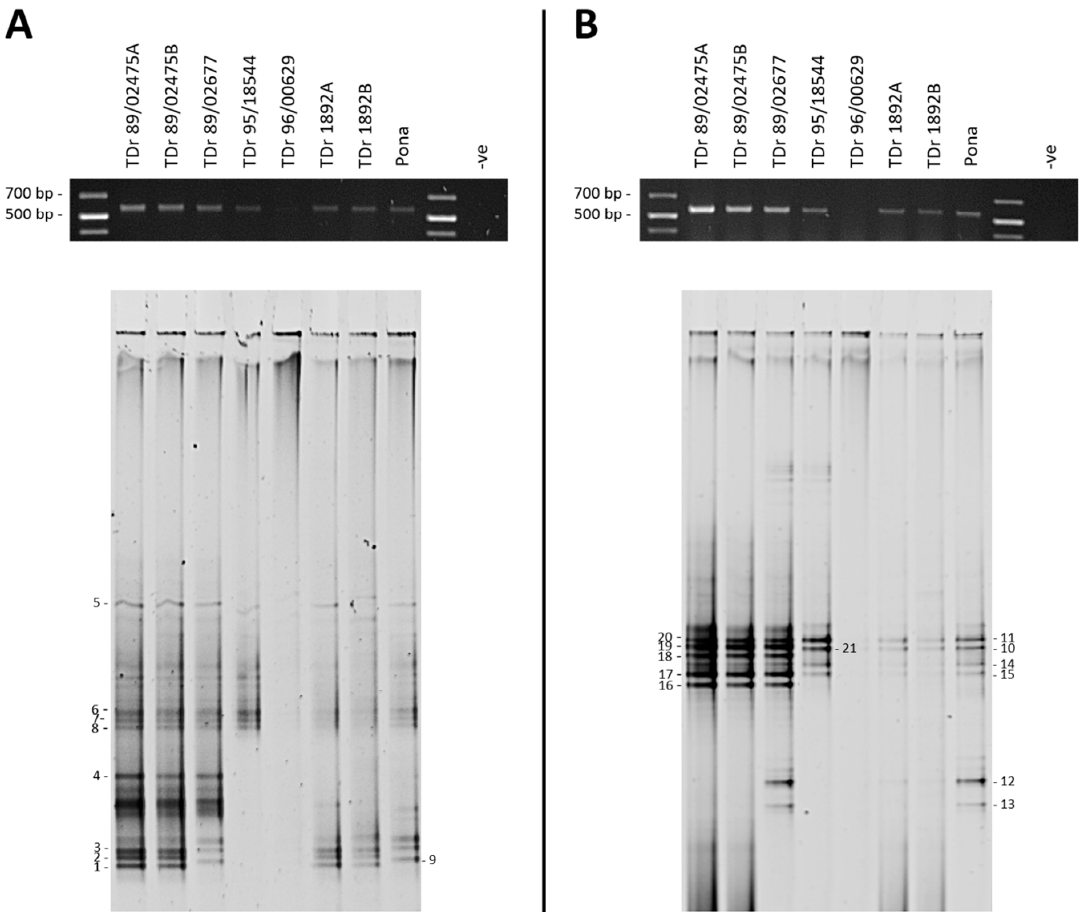
Figure 2. Denaturing gradient gel electrophoresis (DGGE) analysis of partial reverse transcriptase- ribonuclease H (RT-RNaseH) badnavirus sequences from seven Dioscorea rotundata breeding lines and one landrace comparing PCR amplifications using the generic badnavirus primer pair Badna-forward primer/reverse primer (FP/-RP) with a GC clamp fused to the forward ( A ) or reverse ( B ) primer. extractions (‘direct’) and only 25 cycles. PCR amplifications (5 µ L) were checked for their expected